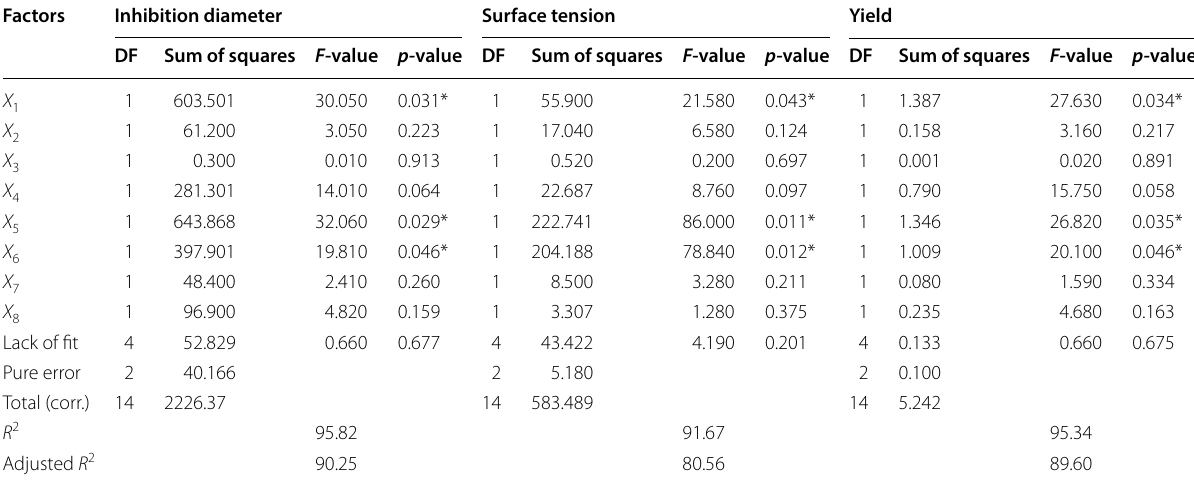
X 1 : Temperature; X 2 : time; X 3 : agitation speed; X 4 : inoculum concentration; X 5 : sugar cane molasses concentration; X 6 : peptone concentration; X 7 : yeast extract concentration; X 8 : K 2 HPO 4 concentration; DF: degrees of freedom; *significant at p < 0.05